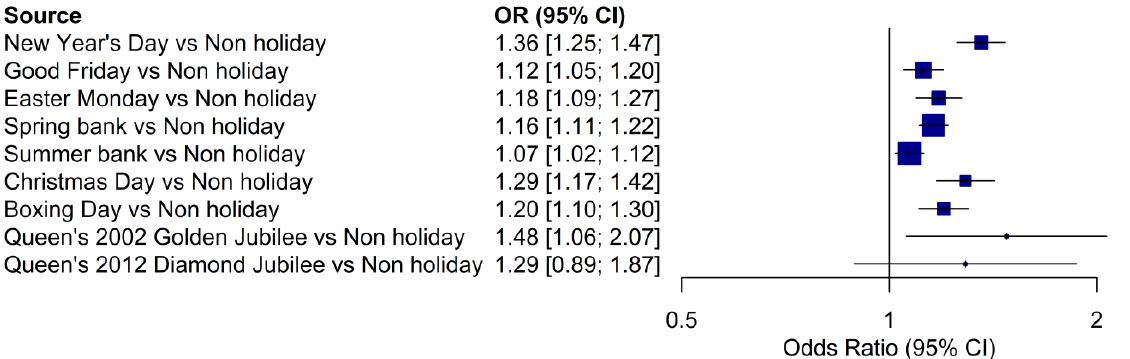
Figure A4. Forest plot of multiple logistic regression result for each independent variables using the UK STATS19 data [24].